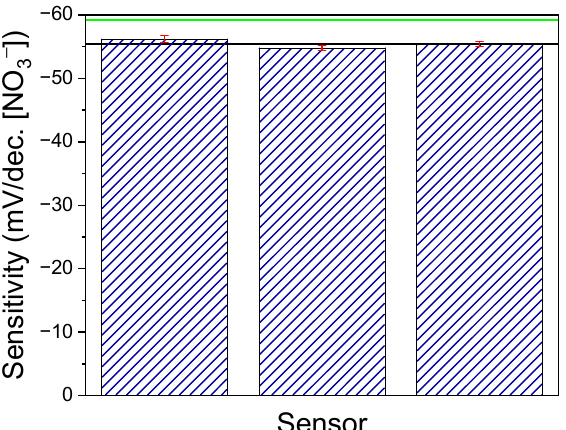
Figure 3. Study of reproducibility of fabrication of sensors (N = 3) by comparing their sensitivity. The green line represents the Nernstian theoretical value ( − 59.2 mV/dec to NO 3 − at 25 °C).